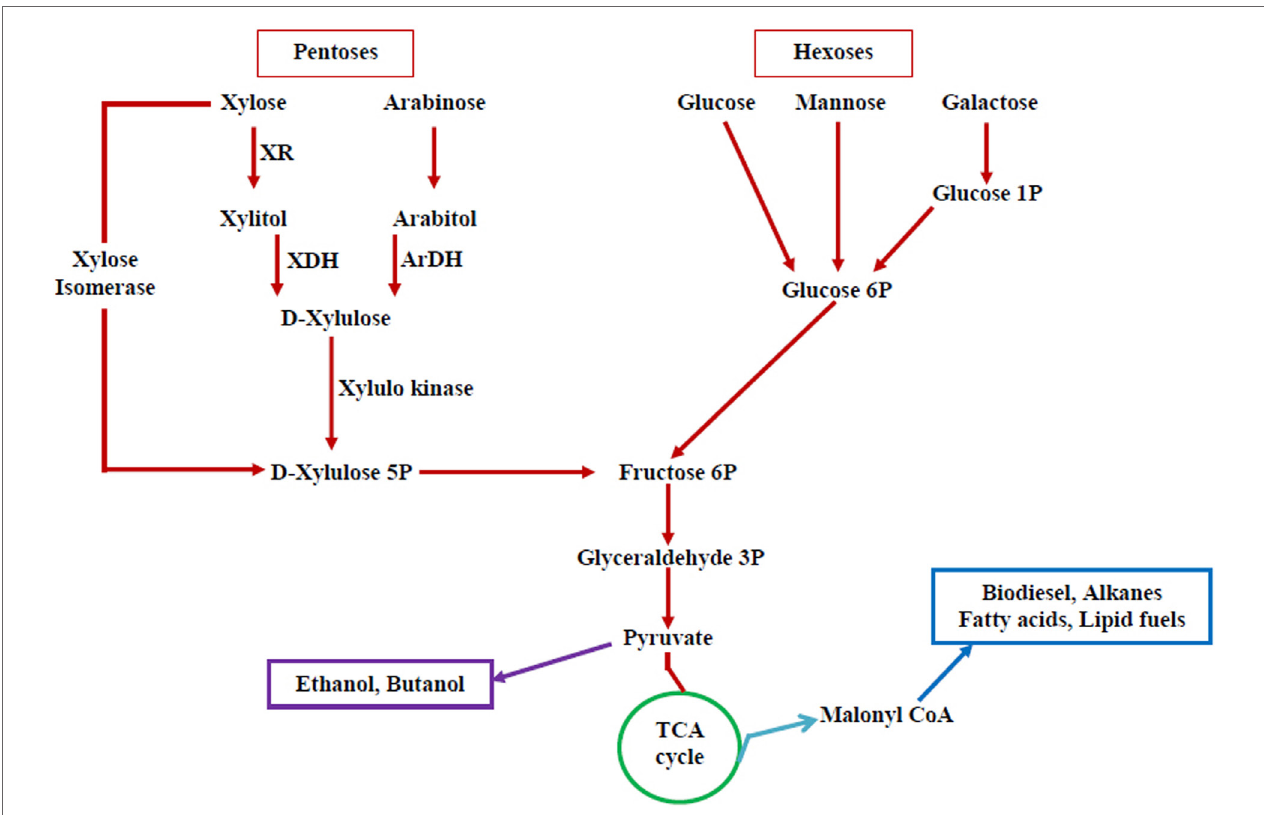
FiGURe 2 | Pentose and hexose utilization pathway in yeasts—possible targets for altering substrate utilization . Pentoses and hexoses, the main components of lignocellulosic biomass that includes xylose, arabinose, glucose, mannose, and galactose and their utilization pathway (XR, xylose reductase; XDH, xylitol dehydrogenase; ArDH, arabitol dehydrogenase). A number of biofuels can be produced from this